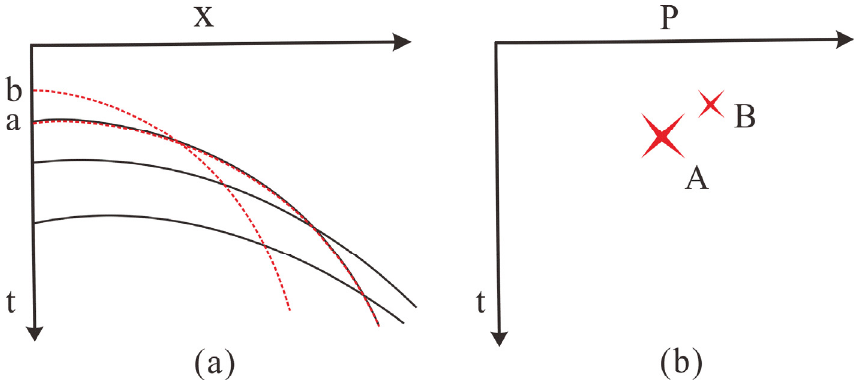
Figure 1. The forward transform of the hyperbolic Radon transform: ( a ) t − x domain; ( b ) Radon domain.